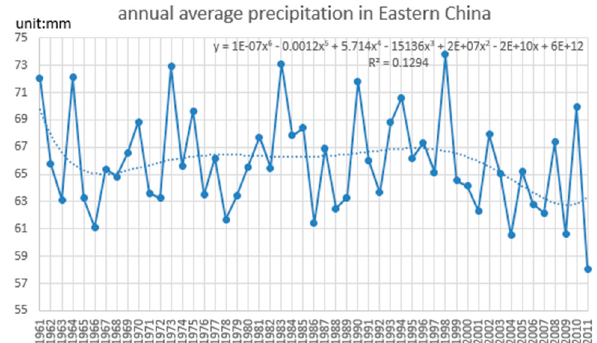
Figure 5. The inter-annual variability of average annual precipitation in eastern China from 1961 to 2011.